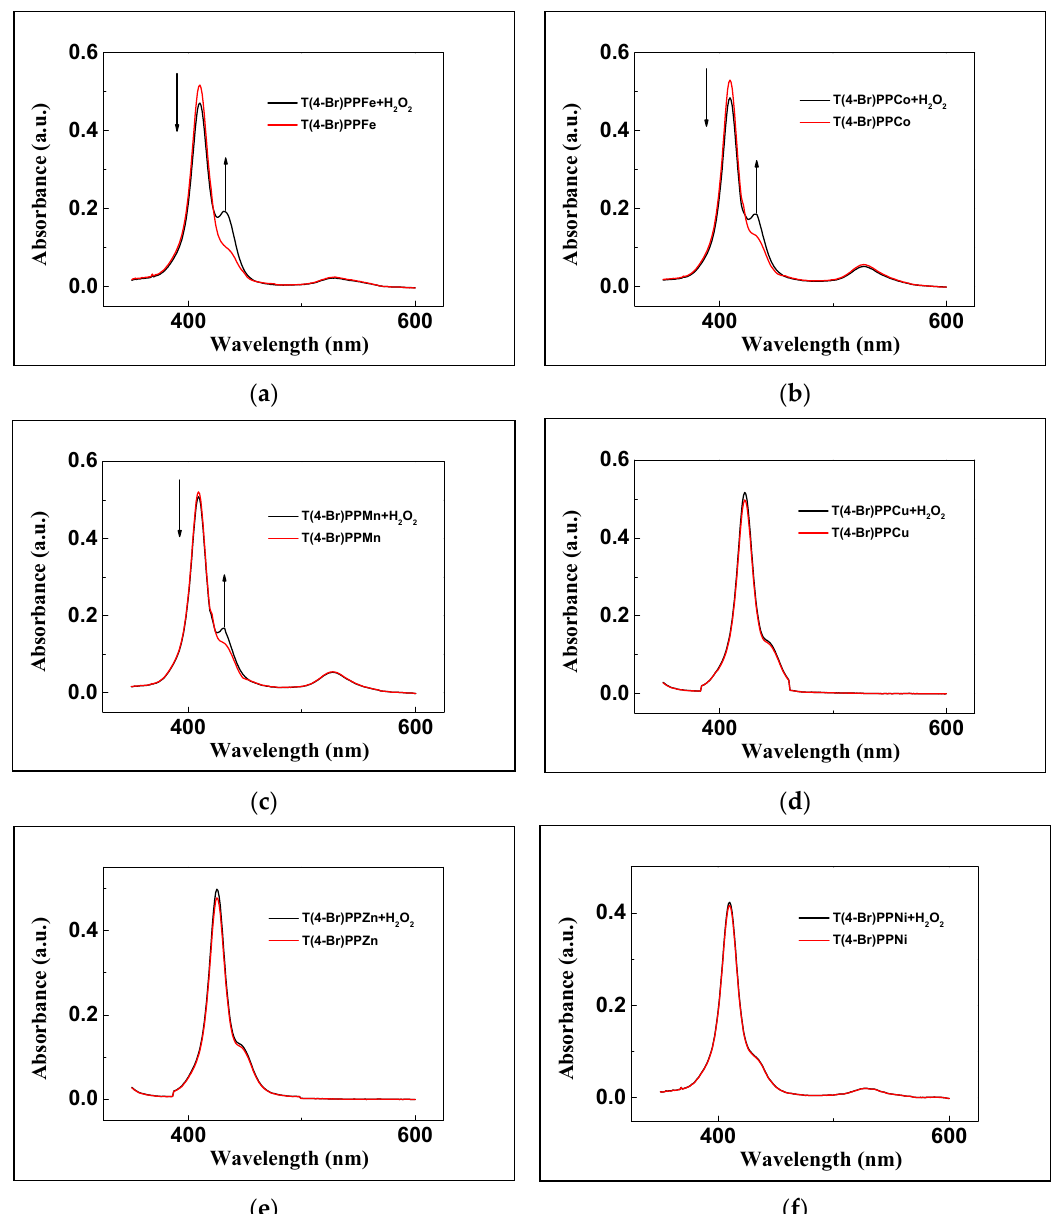
Figure 5. UV-Vis absorption spectra of T(4-Br)PPFe ( a ); T(4-Br)PPCo ( b ); T(4-Br)PPMn ( c ); T(4- Br)PPCu ( d ); T(4-Br)PPZn ( e ); T(4-Br)PPNi ( f ) with H 2 O 2